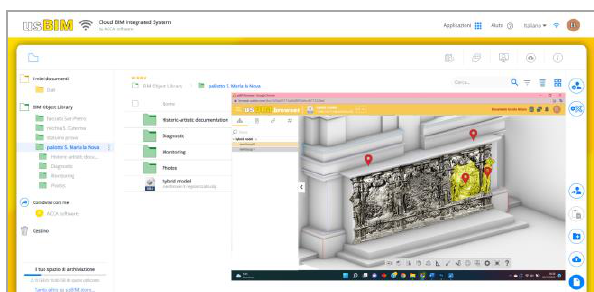
Figure10 . CDE on web sharing collaboration platform. Work in progress: hybrid model and data storage and